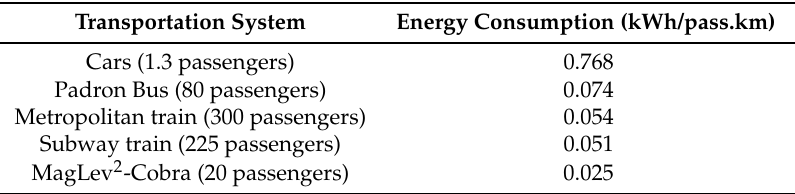
Table 6. Normalized energy consumption of urban transportation systems.